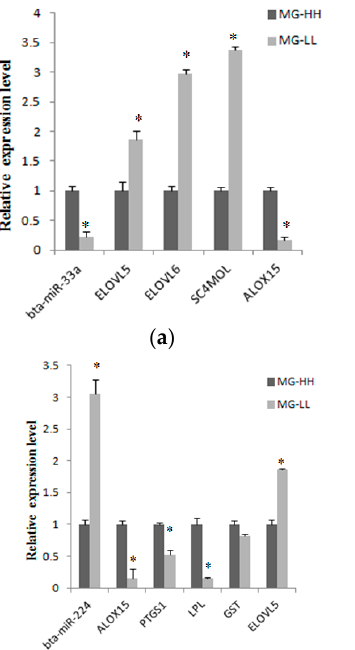
Figure 4. Six miRNAs and their target genes that are involved in milk fat metabolism in bovine mammary gland. The oval color represents the pathway that the target genes involved. Blue oval: Unsaturated fatty acid synthesis. Green oval: fatty acid biosynthesis. Red oval: fatty acid metabolism. Black oval: the targets involved in more than one metabolic pathway. The colored boxes represent the expression trend. Black rectangle: down-regulated miRNAs in pMEC-LL. Blue rectangle: up-regulated miRNAs in pMEC-LL.